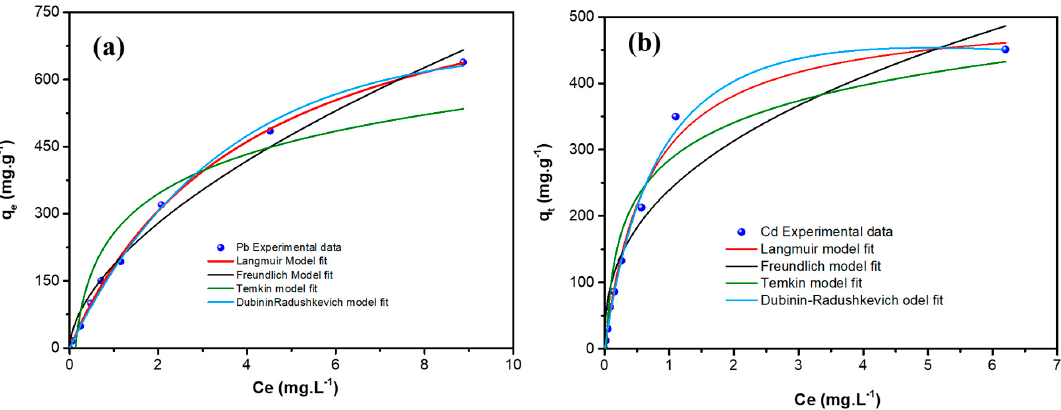
Figure 9. Non-linear Adsorption equilibrium isotherms of ( a ) Pb ++ and ( b ) Cd ++ metal ions onto MGCN sorbent. Table 3. Equilibrium models.